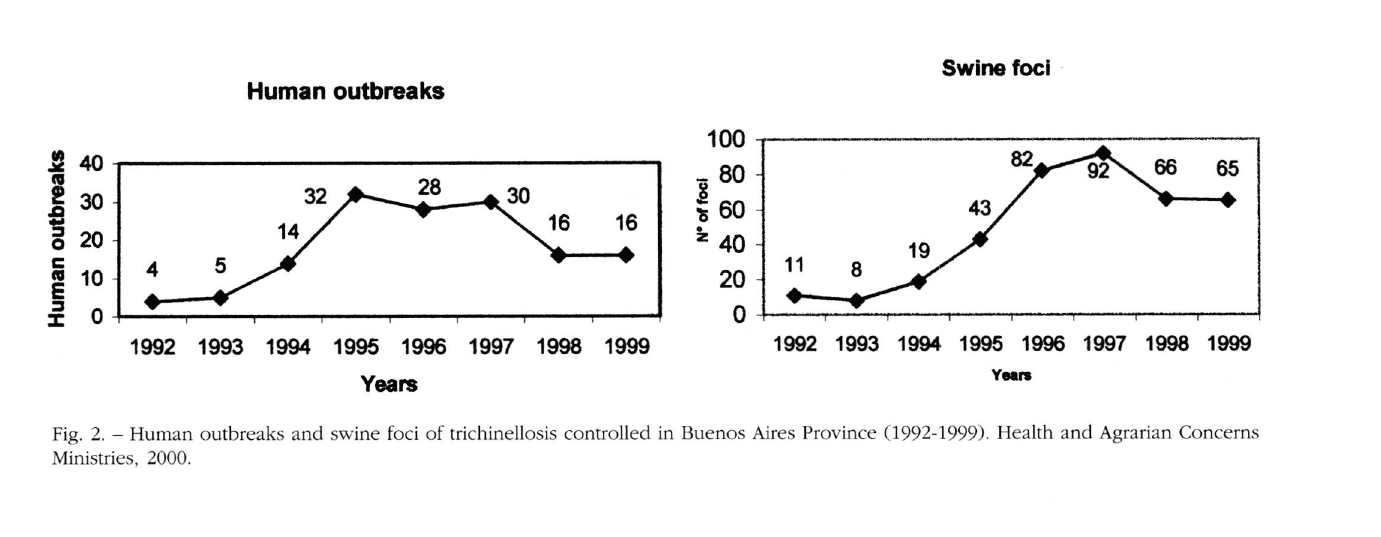
Fig. 2. - Human outbreaks and swine foci of trichinellosis controlled in Buenos Aires Province (1992-1999). Health and Agrarian Concerns Ministries, 2000.